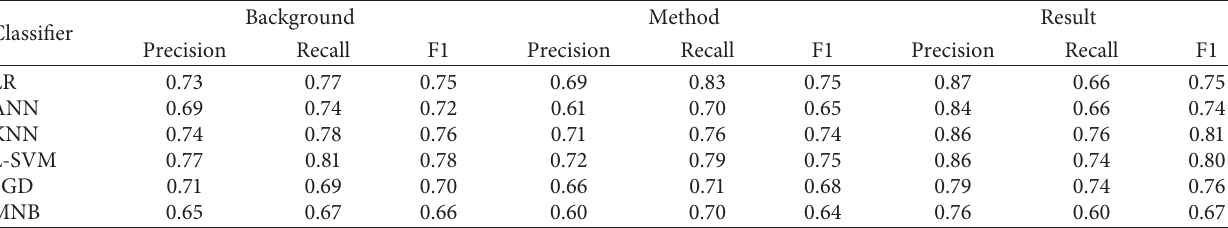
Table 8: Comparison of precision, recall, and F1 score of various classifiers using the SciCite dataset. Background Method Classifier